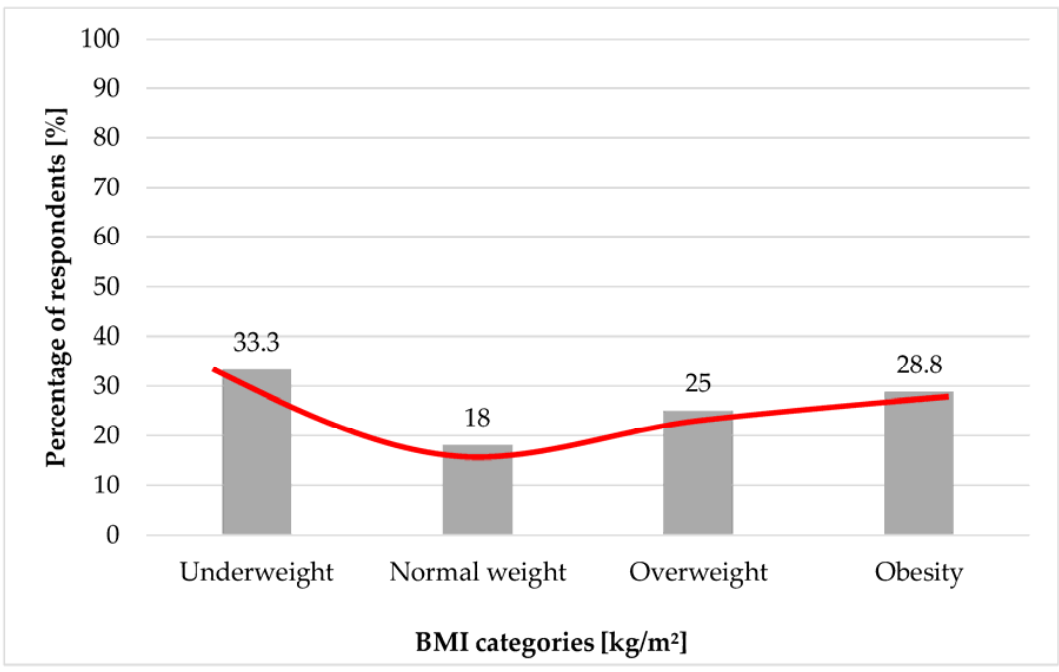
Figure 3. Percentage of individuals presenting a high depression index according to Beck’s scale ( p < 0.001). The red line represents the J-curve. The average result of the total emotional control index was 53 in the study group. Patients with normal BMI achieved 53.4 points, underweight women 52.5, overweight pa- tients 52.6, and obese women 52.8. These data are presented in Figure 4. The mean level of the Anger subscale was 15.7, of the Depression subscale 19.1 and of the Anxiety sub- scale 18.2. The mean scores in all groups of women were comparable. There were no sig- nificant statistical differences between BMI and the results of the CECS scale ( p > 0.05). Only the level of Anger suppression was on the verge of statistical significance depending on BMI ( p = 0.08) (Table 2). Figure 4. CECS- Total score depending on BMI ( p = NS).